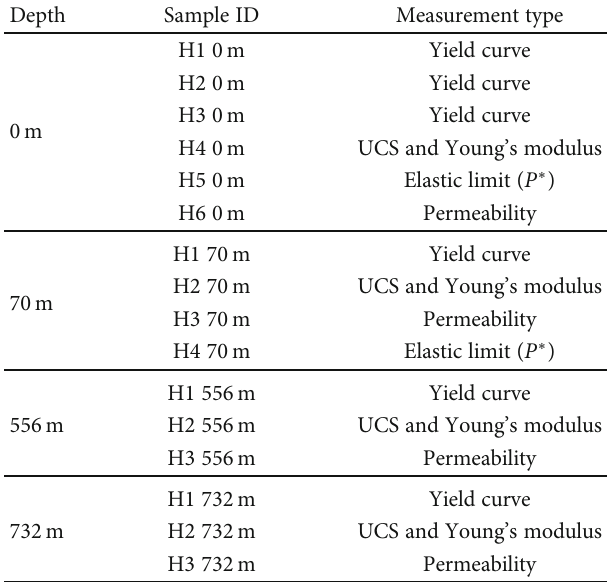
Table 1: Sample suite and test types